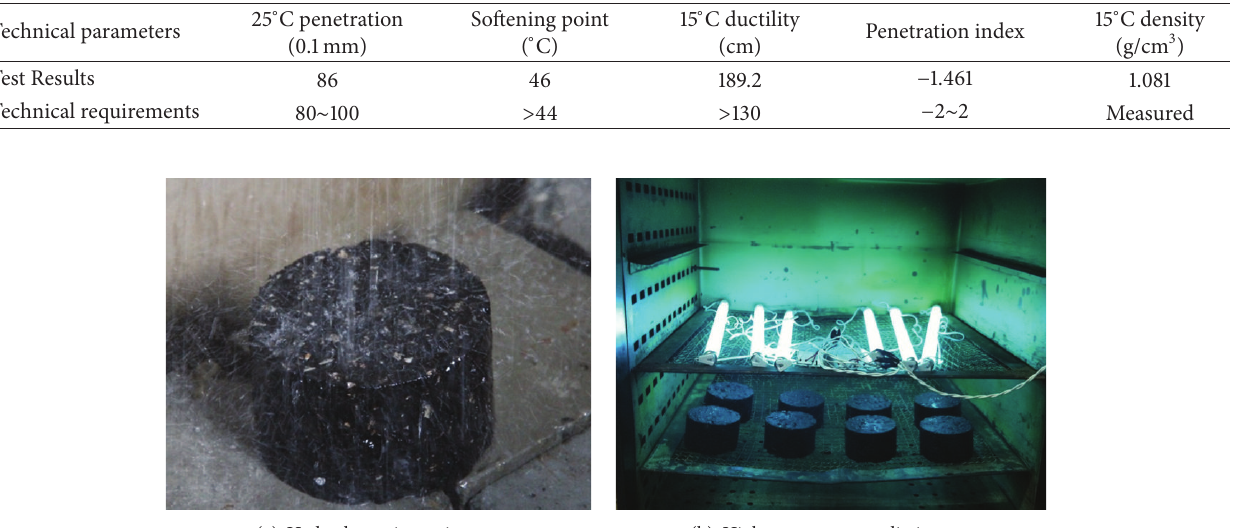
Table 1: The technical parameters of tested asphalt.